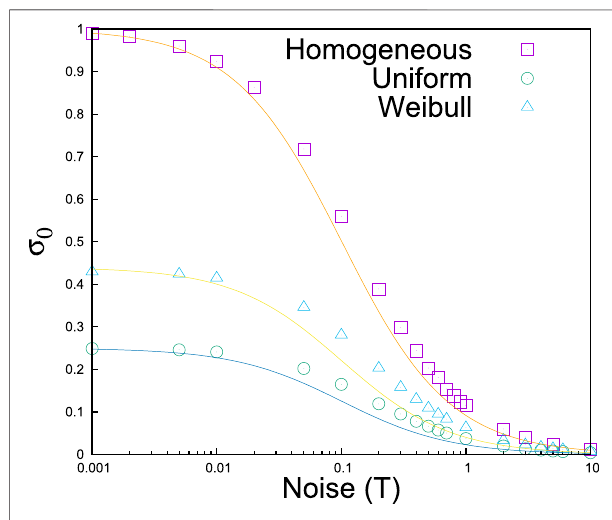
FIGURE 6 | Phase boundary ( σ 0 vs. T plot) for three different types of fi ber strength distributions with N (cid:1) 20000. Data points are simulation results andsolidlinesareanalyticestimates( Eq.50 )basedonmean- fi